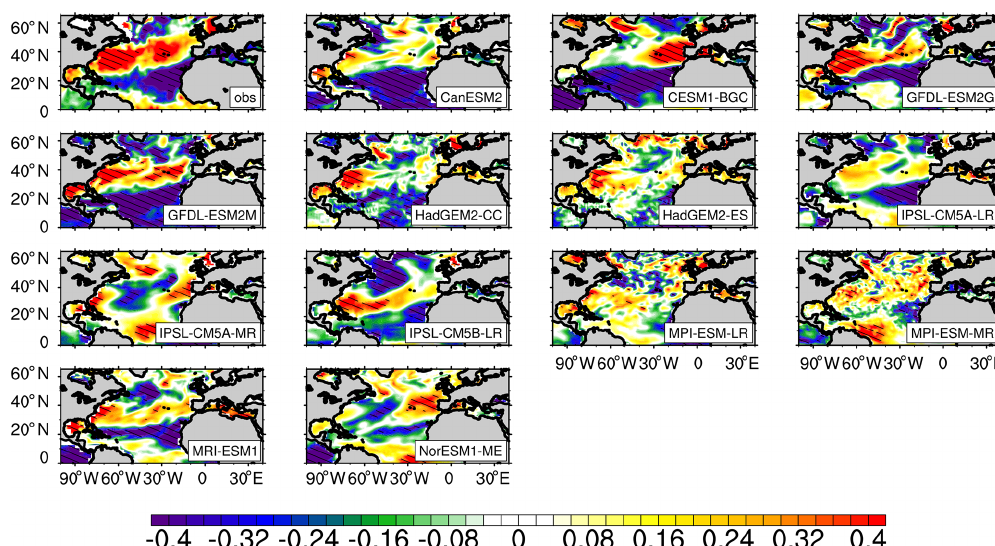
Figure 4. Observed and simulated standardized regression coefficients (RCs) of the winter-average SST anomalies against the NAO indices on an interannual scale (with 2–6-year data filtering). Shaded areas indicate that RCs are statistically significant at the 95% confidence level of Student’s t test. The obs is the RCs of observed SST to the NAO indices provided by NCAR. The time periods for the observation and models range from 1965 to 2015 and from 1955 to 2005, respectively. The simulated results are based on a historical experiment of CMIP5 (r1i1p1).